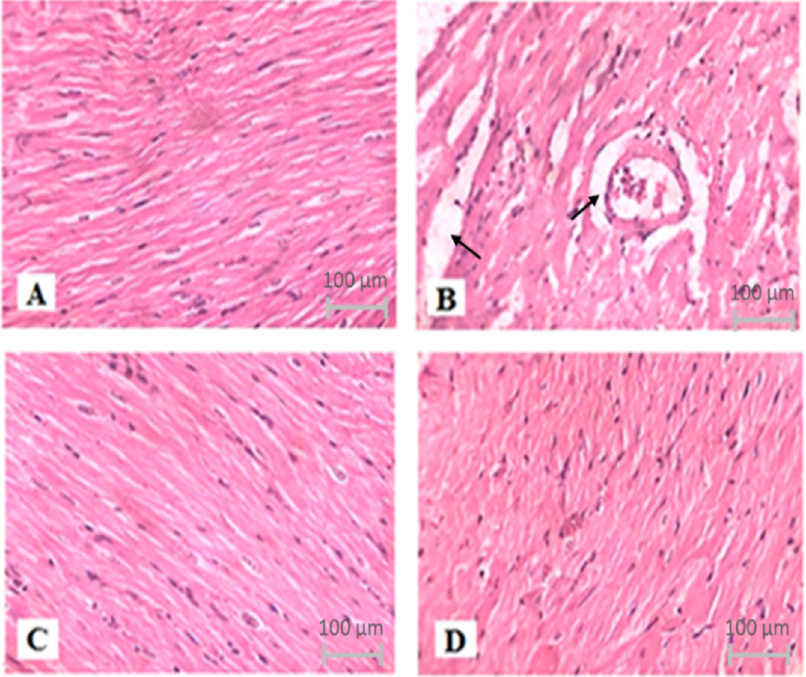
Figure 7. The effect of TQ on histopathological changes in ISO-induced myocardial infarction in rats. ( A ) Normal, ( B ) ISO, ( C ) TQ, and ( D ) TQ + ISO. Heart tissues were stained with hematoxylin and eosin and visualized under a light microscope at 400× magnification. ISO: isoproterenol; TQ: thymoquinone.